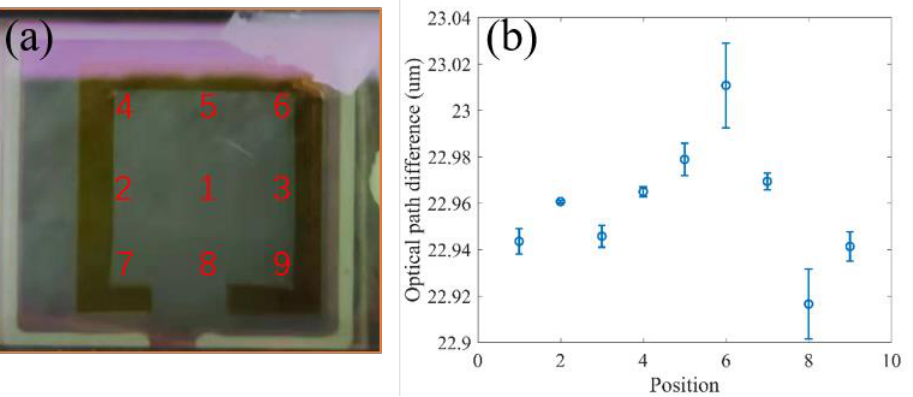
Figure 5. ( a ) Position of the measuring points for the LC. ( b ) Optical path difference and error bar at each position.